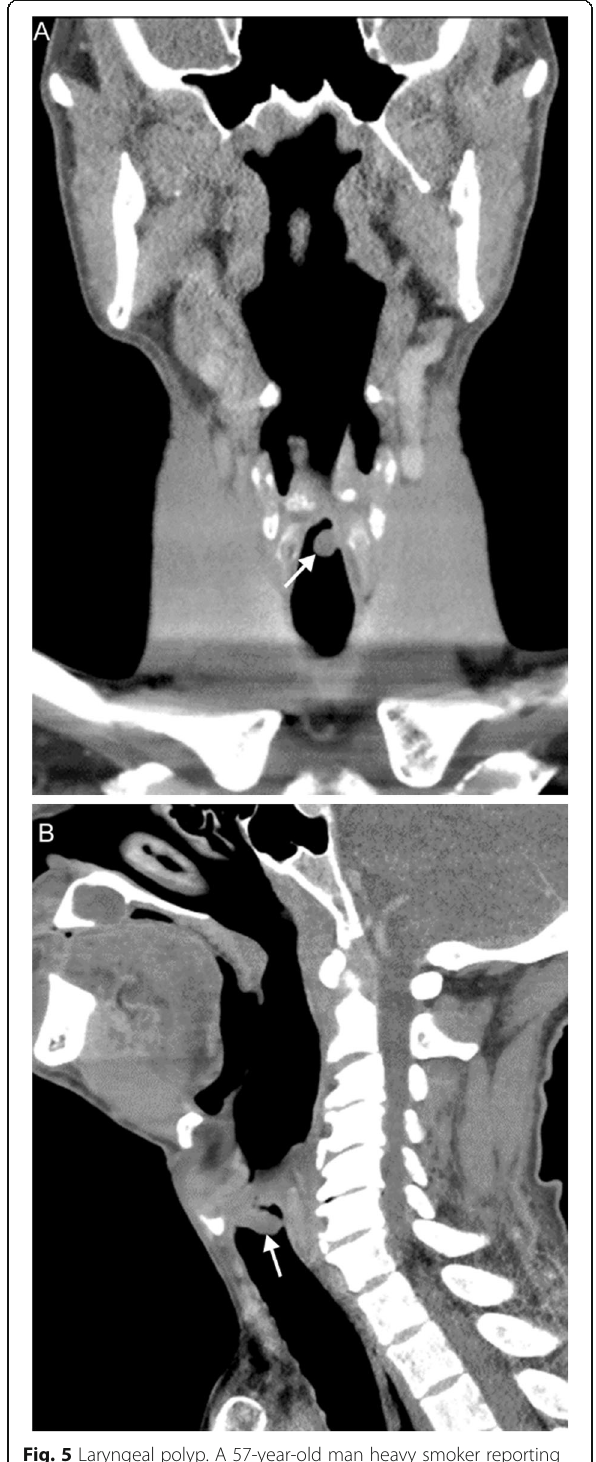
Fig. 5 Laryngeal polyp. A 57-year-old man heavy smoker reporting sore throat, hoarseness, and stridor. Coronal ( a ) and sagittal ( b ) contrast-enhanced CT images reveal a polypoid lesion arising from the left wall of the larynx (arrows). Laryngoscopy (not shown) revealed a round mass with ball-valve obstruction of the glottis. Subsequent biopsy confirmed a laryngeal